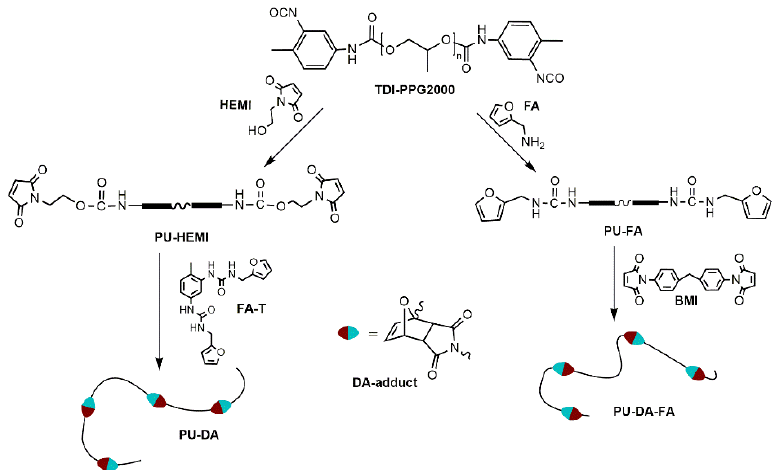
Table 1. Molecular mass characteristics of PU-DA and PU, derived from furan-terminated prepoly- mer.